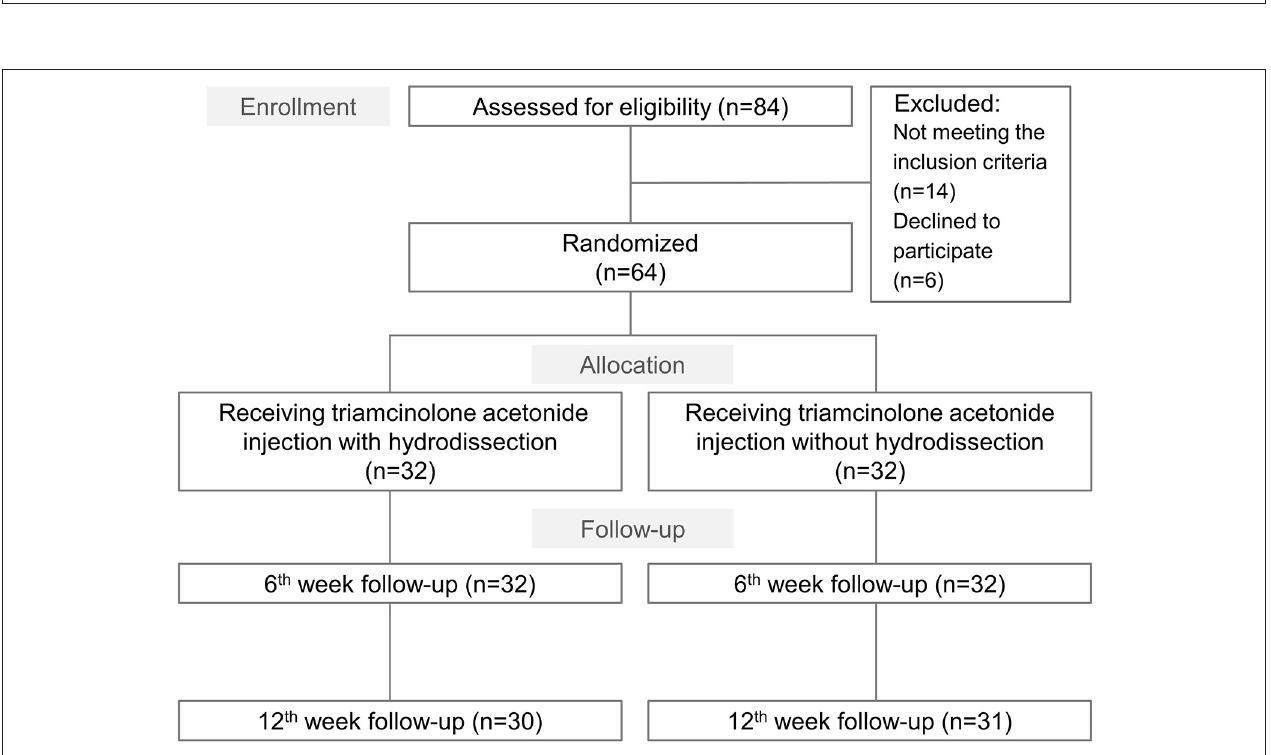
FIGURE 2 | Study flow diagram for the group receiving ultrasound guided triamcinolone acetonide injection with hydrodissection and that undergoing triamcinolone acetonide injection alone.